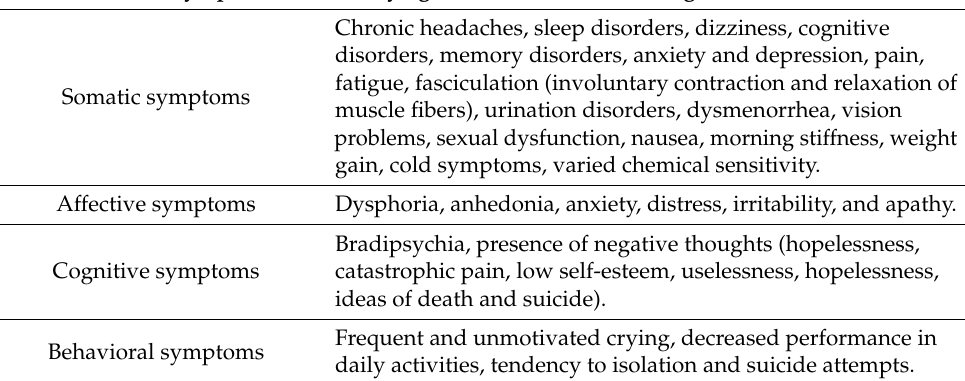
Table 1. Databases